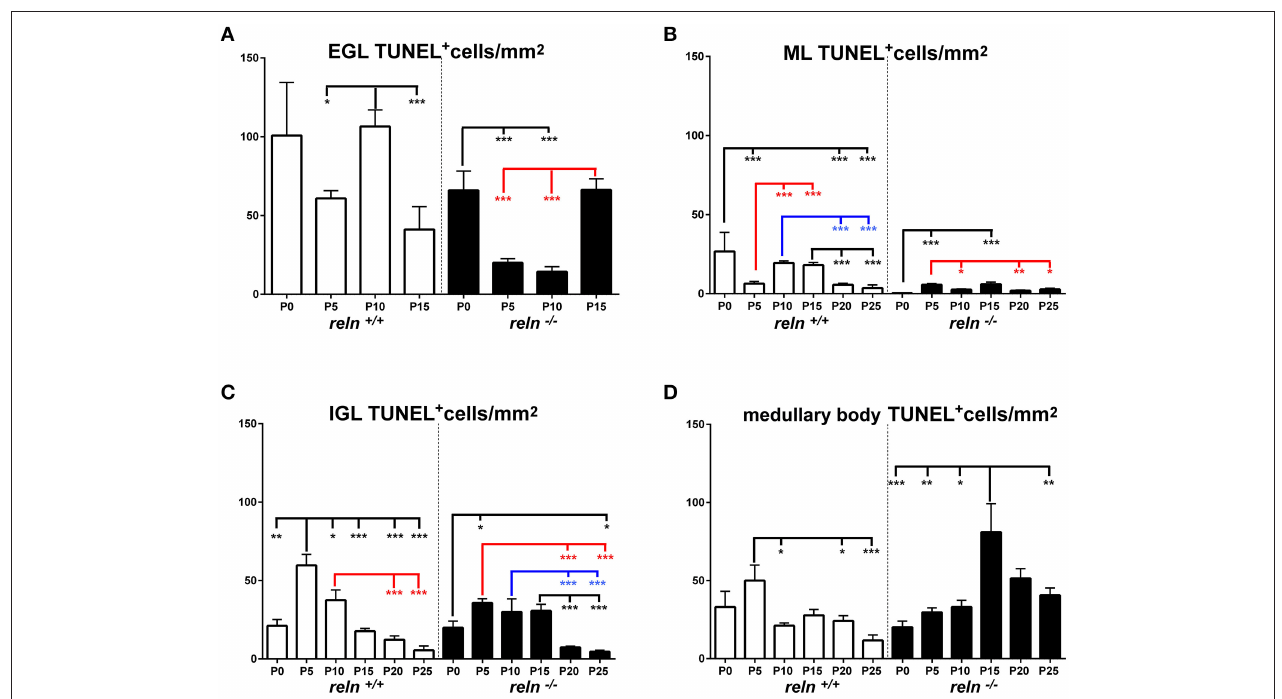
FIGURE 6 | Comparison of PrCD within genotypes. Cortical layers (A–C) , medullary body (D) . EGL, external granular layer; ML, molecular layer; P, postnatal age; One-way ANOVA with multiple comparisons; error bars indicate SEM; *** P < 0.001; ** P < 0.01; * P < 0.05.